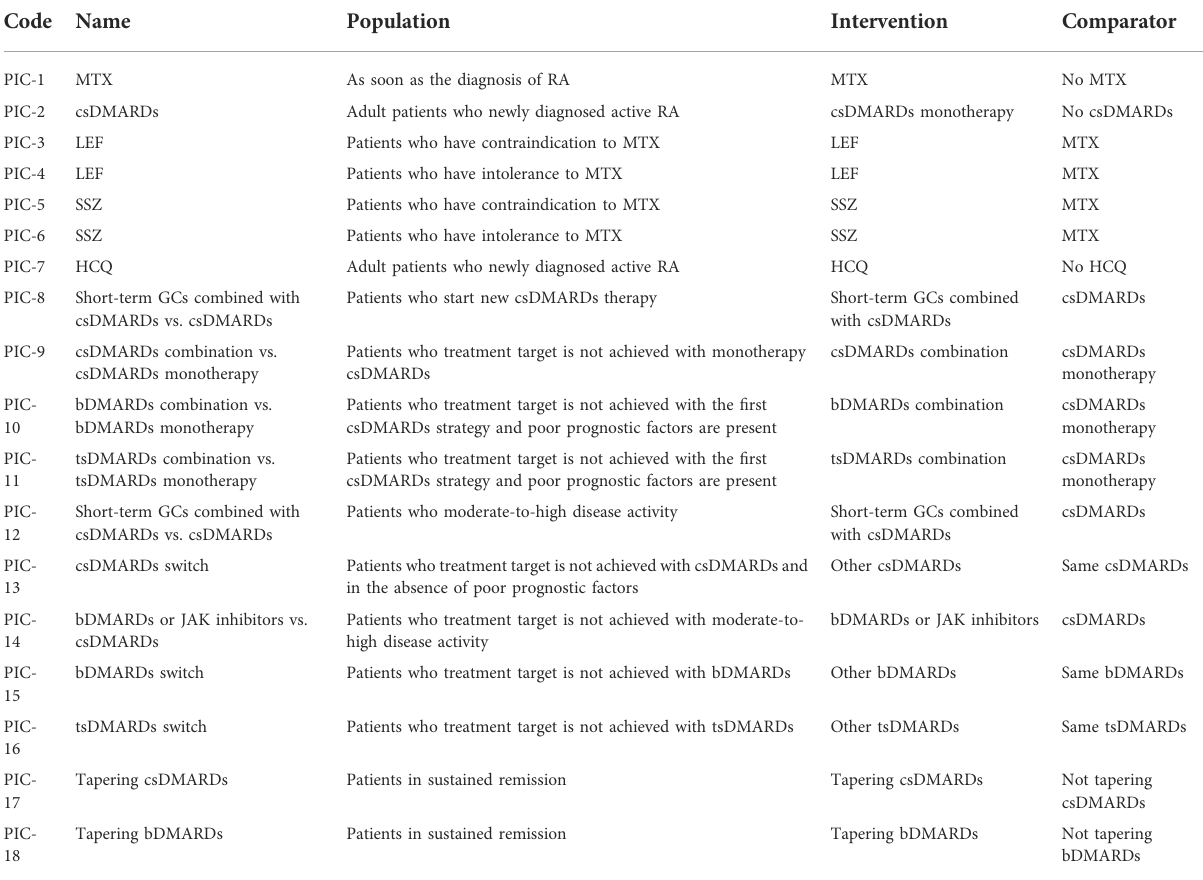
TABLE 1 Population-intervention-comparator speci fi